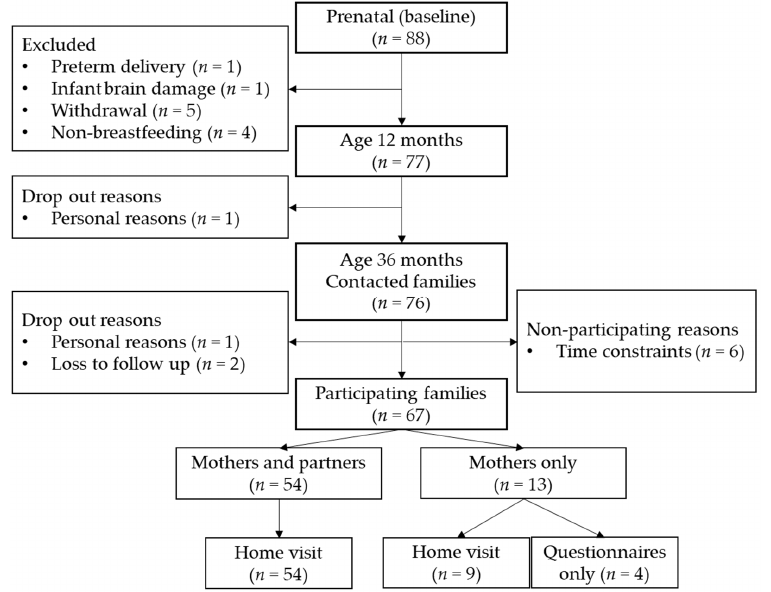
Figure 1. Flowchart of participant follow-up. Drop-outs are shown on the left side of the flowchart. Participants who skipped the assessment round are shown on the right side of the